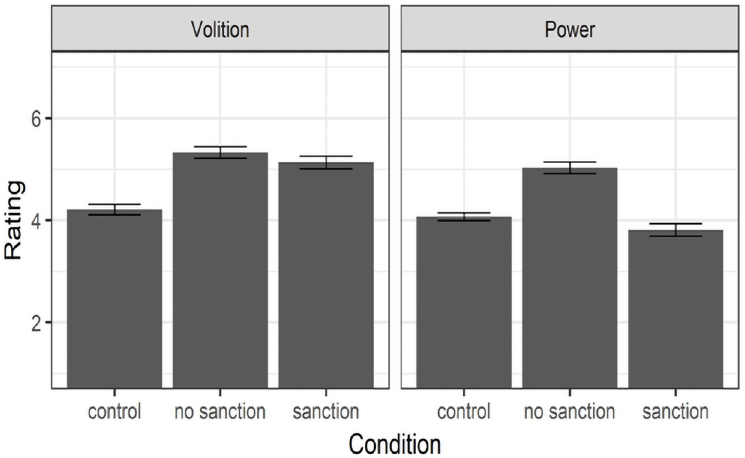
Fig 5. Means and standard errors for the effects of norm abidance (control), norm violation (no sanction), and sanctioned norm violation (sanction) on inferences of volition and power in Study 2.